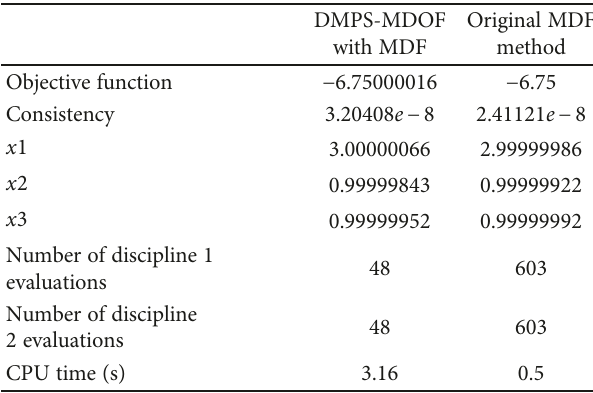
Table 1: Comparison between DMPS-MDOF with MDF and the original MDF